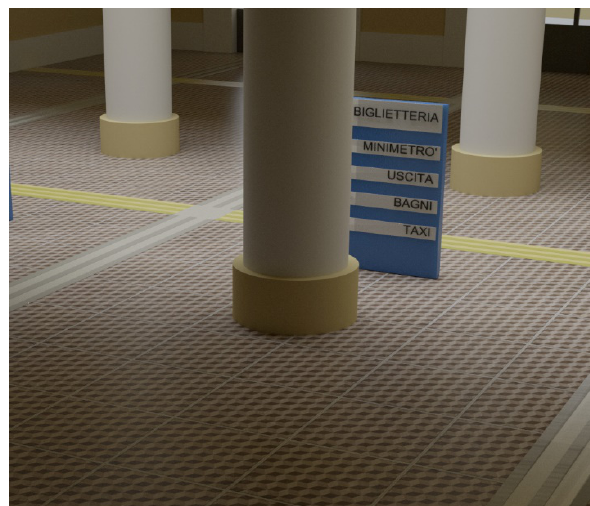
Figure 4. Detail of the three-dimensional model.